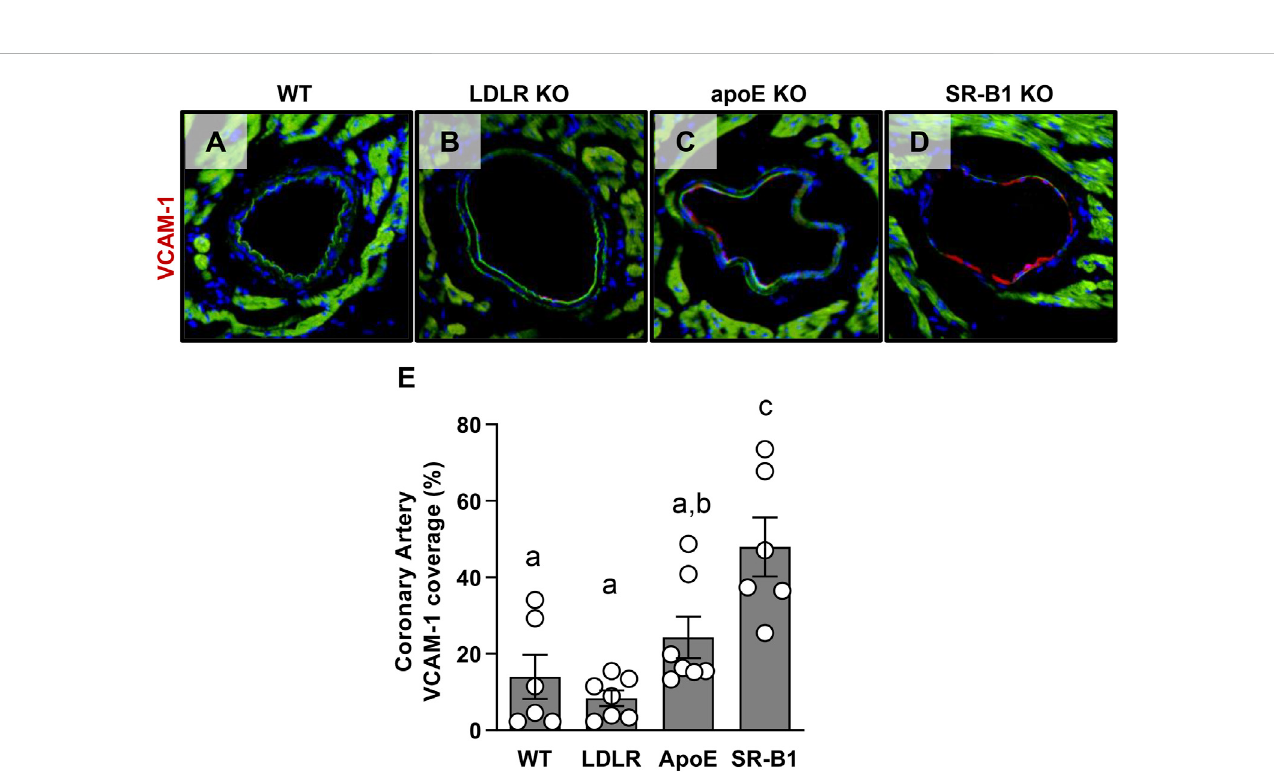
FIGURE 6 Expression of VCAM-1 in coronary artery endothelial cells in HFCC-fed female WT, LDLR KO, ApoE KO and SR-B1 KO mice. Coronary arteries in transverse cryosections of myocardium were stained for VCAM-1 expression by immuno fl uorescence. Representative images of VCAM-1-stained coronary arteries from mice from each indicated genotype group are shown in (A – D) . The length VCAM-1 positive staining in coronary artery endothelium was measured using ImageJ software and expressed as a percentage of total artery endothelium length (the cumulative circumference of each artery counted). (E) VCAM-1 for 6-7 mice per group. Individual symbols represent samples from individual mice and bars with error bars represent average ± SEM. Different letters indicate statistically signi fi cant differences from one another by one-way ANOVA with Tukey ’ s post-hoc test. Overall ANOVA: p = 0.0002; multiple comparisons: p < 0.002 a vs. c; p = 0.026 b vs.